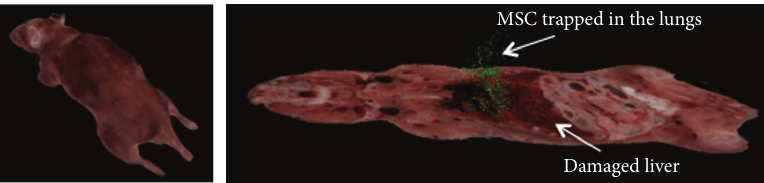
Figure 4: In vivo cryoimaging of labeled MSC. MSC labeled with Qtracker 605, which stains live cells and infused directly after and imaged 2 hours after hepatic IRI are present in the lungs and not in the damaged liver. Many of the liver MSC are trapped in the lungs, but the majority of infused cells cannot be detected, suggesting that these cells are